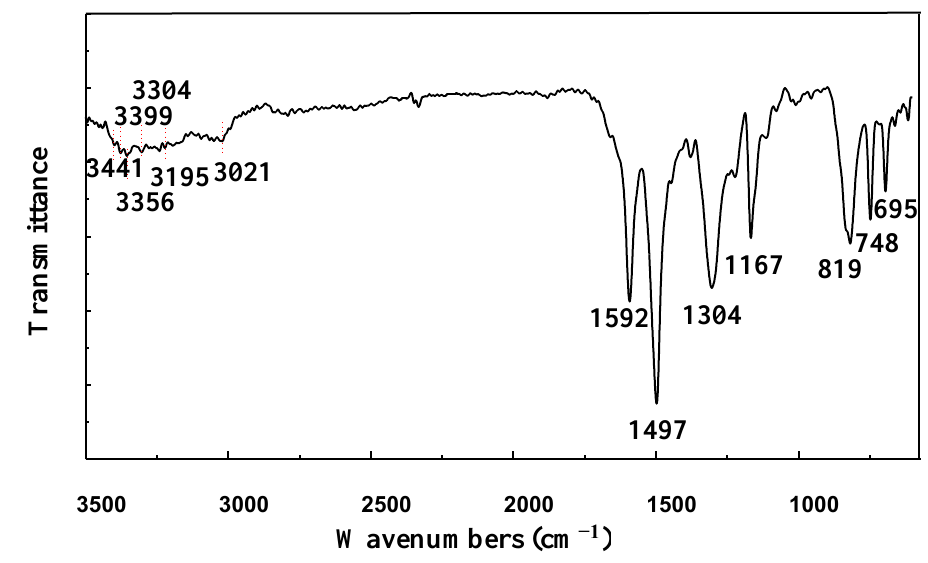
Figure 2. FTIR spectra of aniline tetramer.